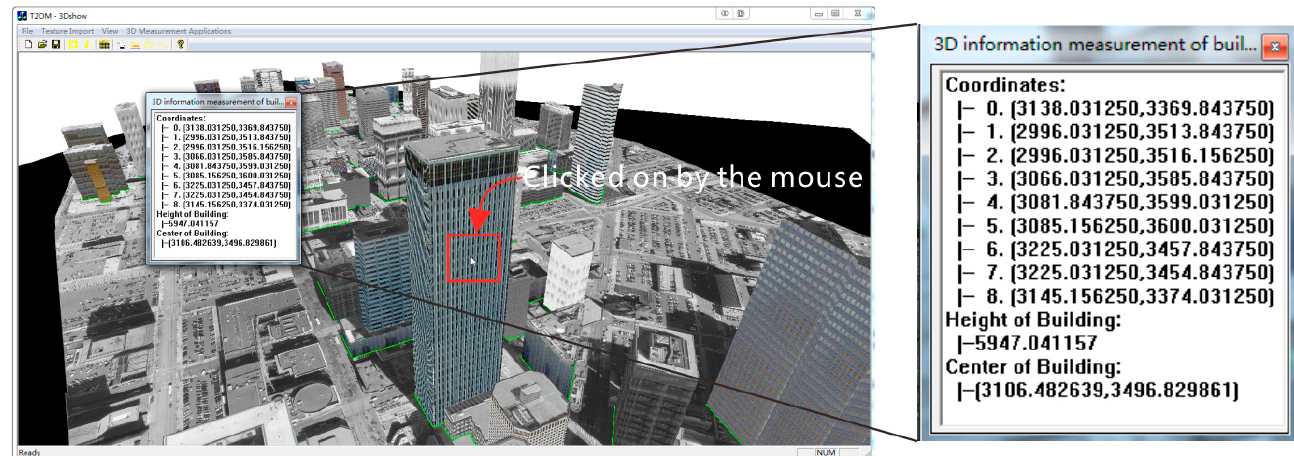
Figure 23. Selectively showing or hiding information.